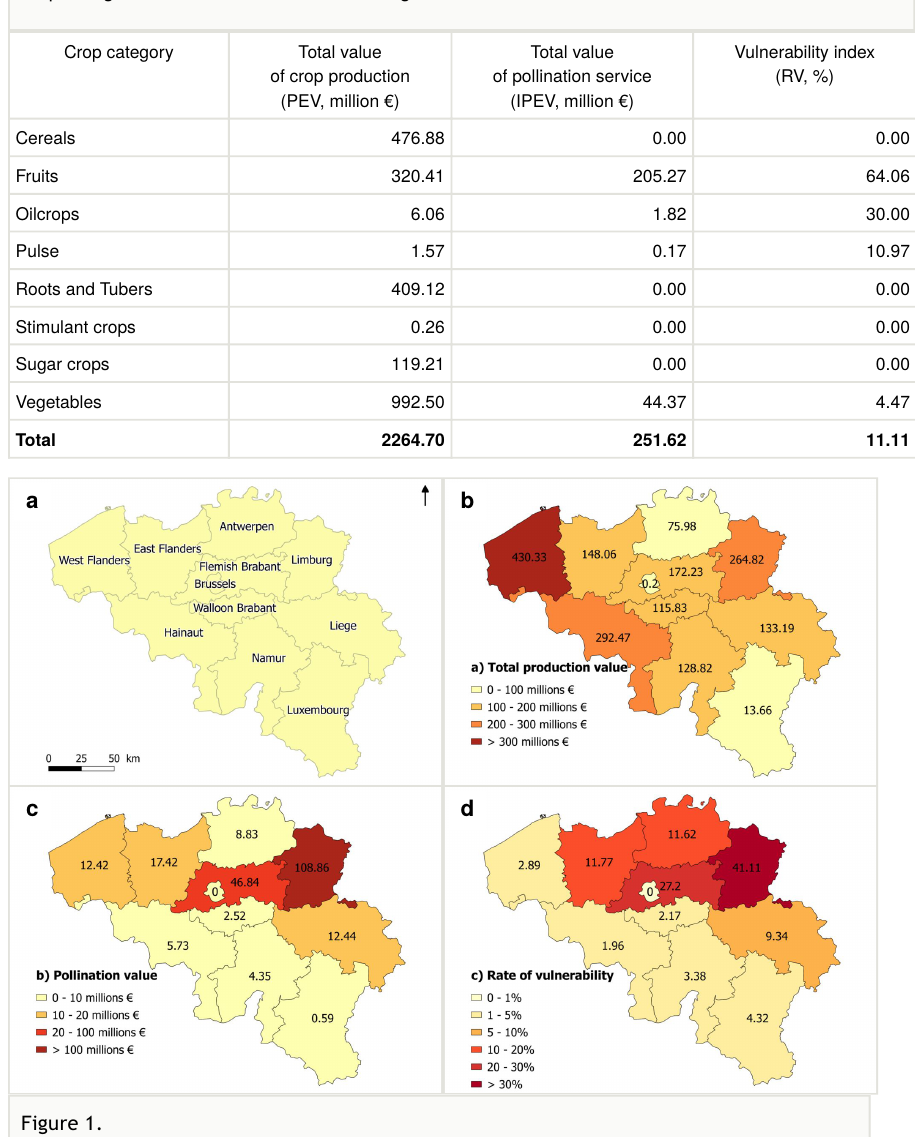
Total value of crop production (PEV, €), pollination service (IPEV, €) and vulnerability (RV, %) of crop categories used as human food in Belgium in 2010.